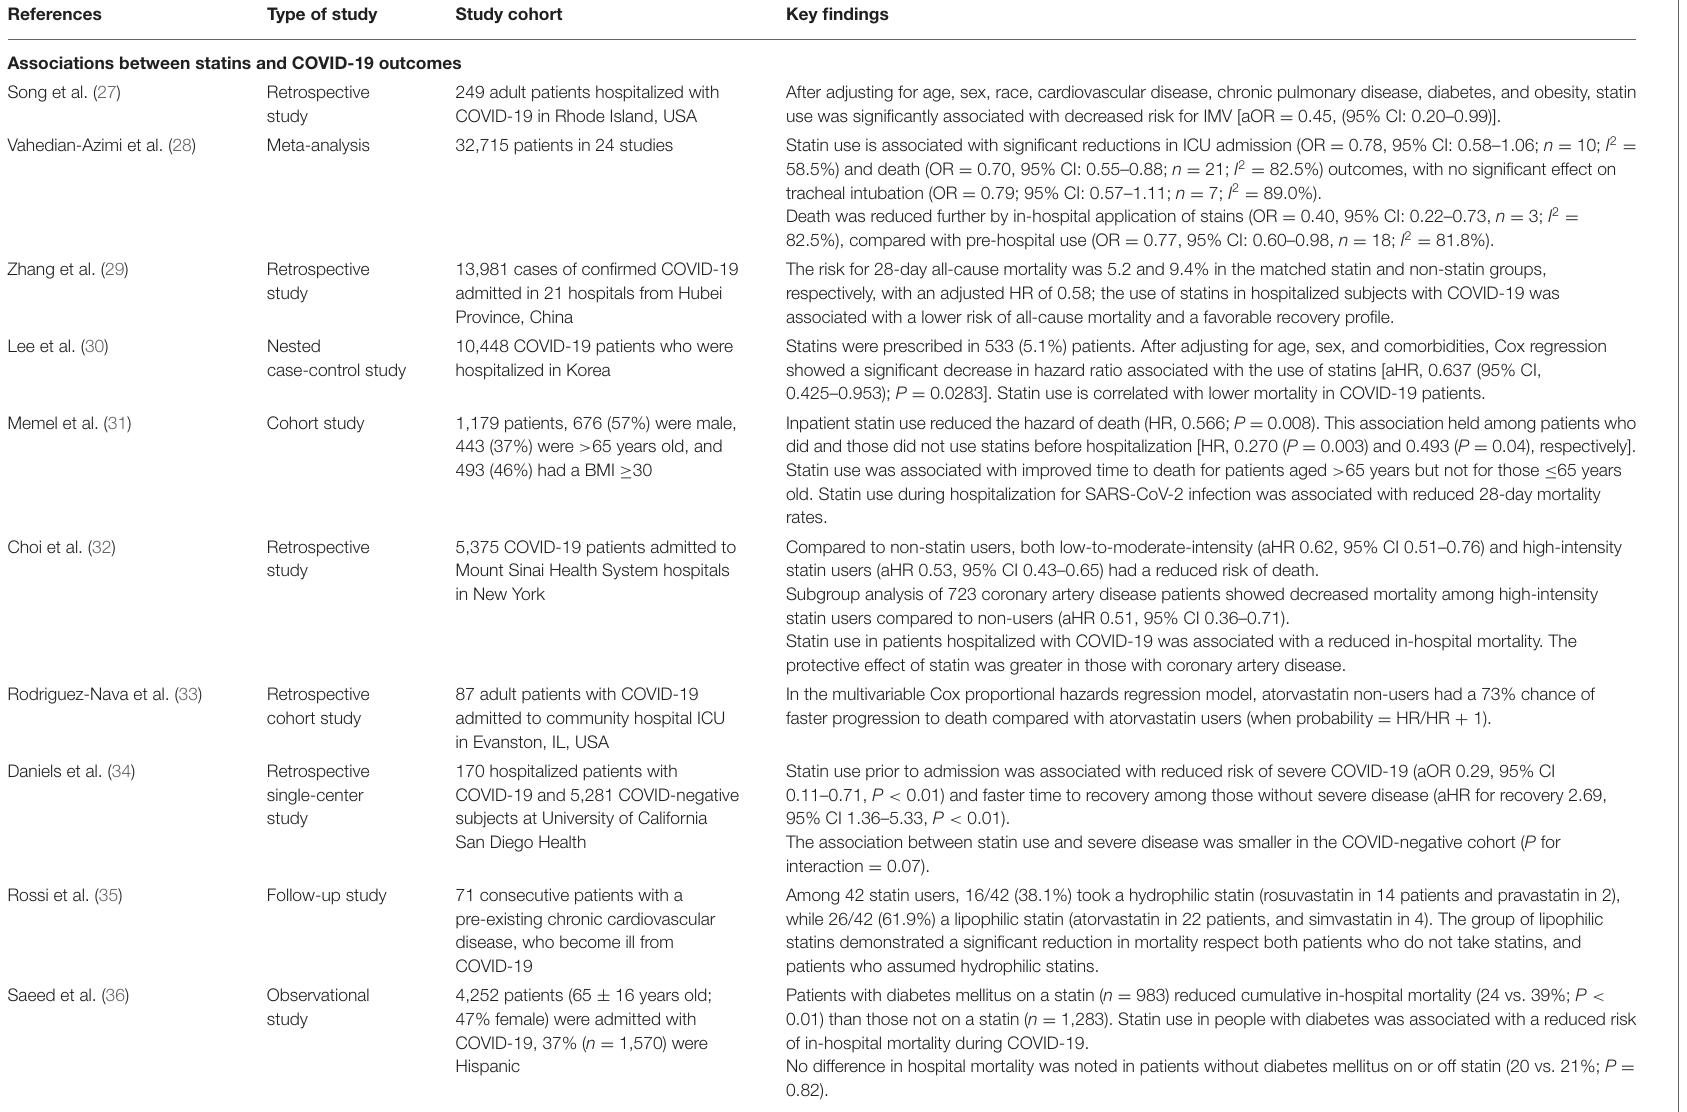
TABLE 1 | Associations between statins and COVID-19 outcomes, and clinical trials regarding statin use in